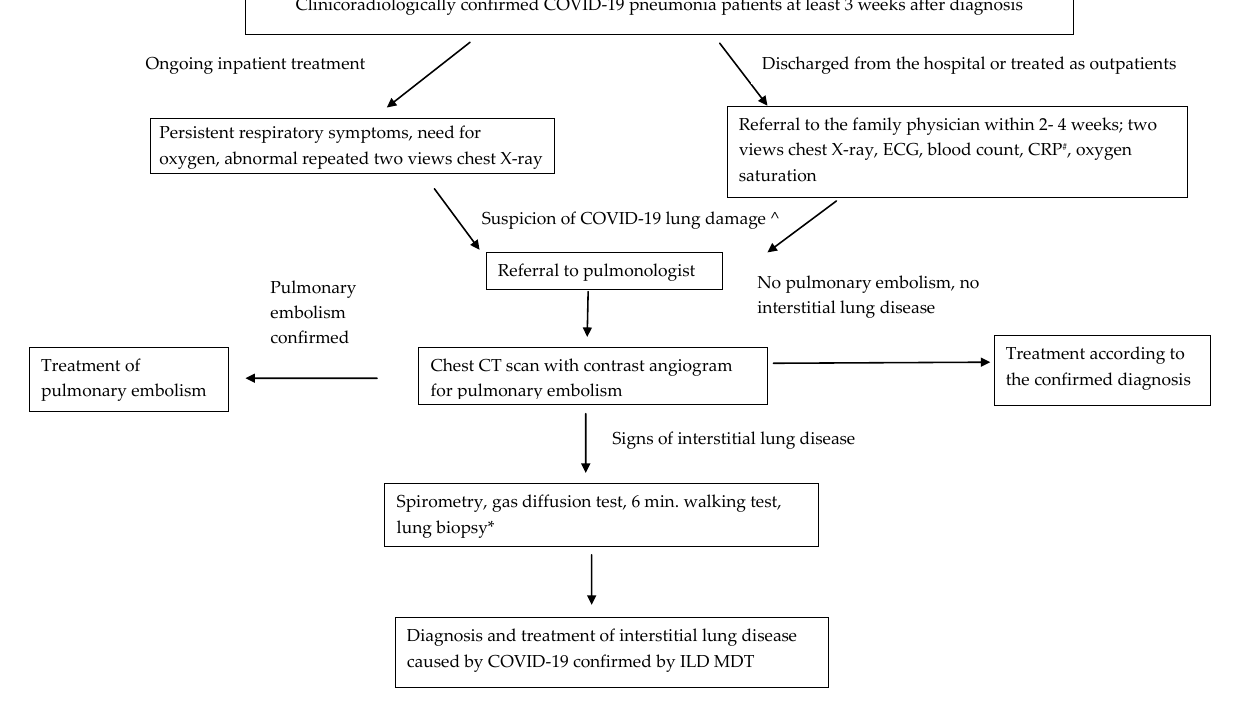
Figure 3. Management algorithm for early diagnosis of lung disease after COVID-19